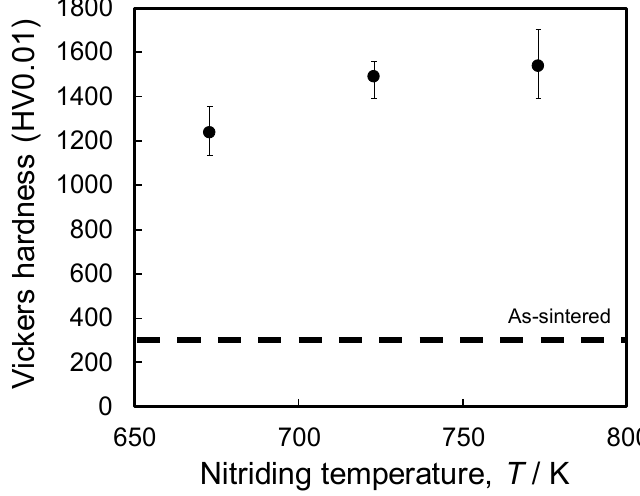
Figure 11. Surface hardness of plasma-nitrided CoCrFeMnNi samples.